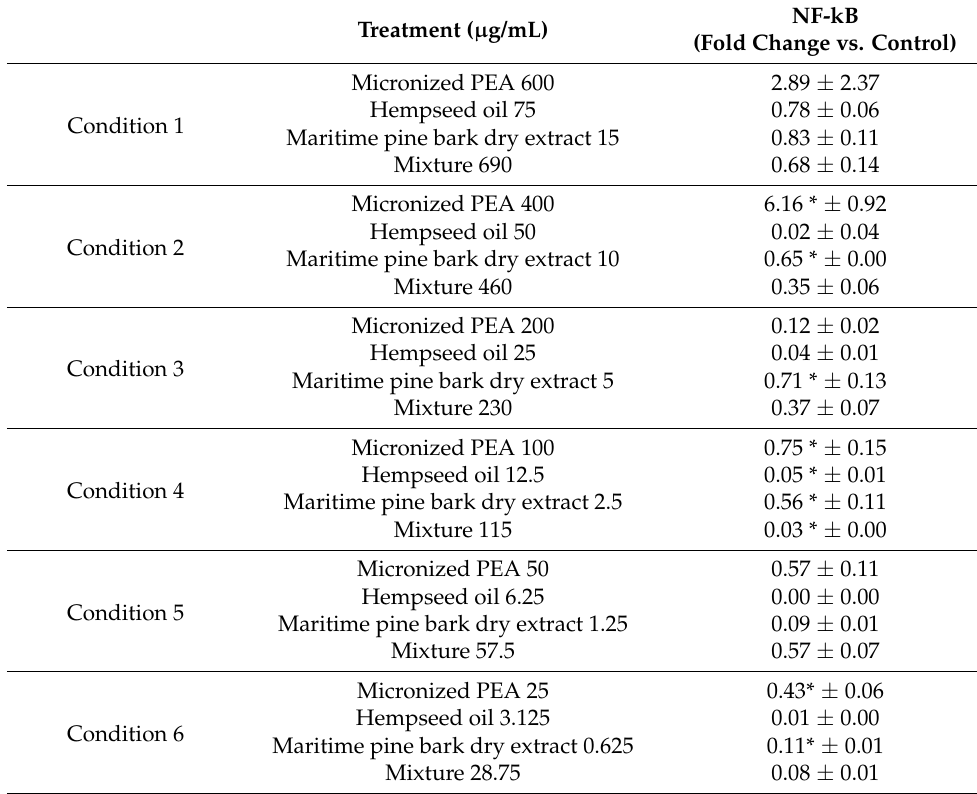
Table 2. Nuclear levels of the transcription factor NF-kB expressed as fold changes compared to control (cells treated with medium conditioned only with the inflammatory stimulus, E. coli ) after treatment of bladder urothelium cells with the three functional ingredients and their mixture at different concentrations. * indicates statistical significance set at p < 0.05 for the comparison between the mixture and each ingredient singularly